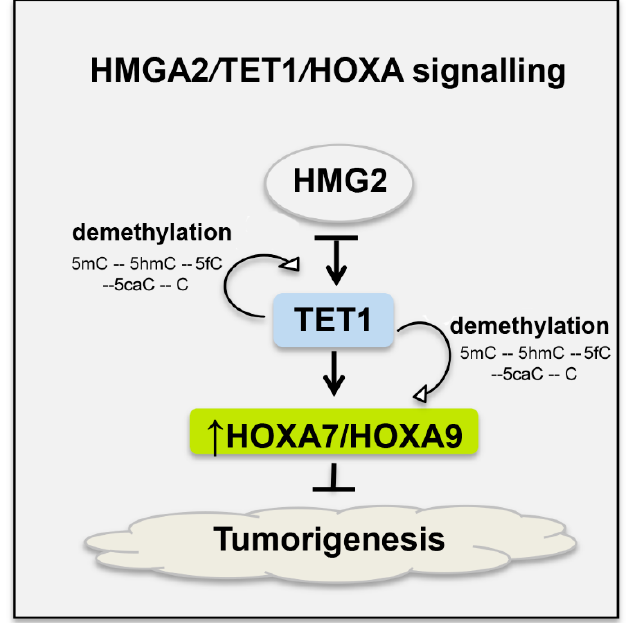
Figure 2. HMGA2/TET1/HOXA signalling in breast cancer cells. Depletion of the architectural transcription factor high mobility group AT-hook 2 (HMGA2) induces TET1 (ten–eleven translocation methylcytosine dioxygenases). This mole- cule initiates demethylation of DNA and is associated with tumorigenesis in many cancers. TET1 binds and demethylates its own promoter and the promoters of HOXA7 and HOXA9 , increasing their expression, which may result in the inhibi- tion of breast cancer growth and metastasis, already demonstrated for HOXA9 using mouse xenografts [35]. The demeth- ylation promoted by TET1 allows the conversion of 5-methylcytosine (5mC) to 5-hydroxymethylcytosine (5hmC) and this to 5-formylcytosine (5fC), which in turn is converted in to 5-carboxycytosine (5caC) and at the end in an unmodified cytosine